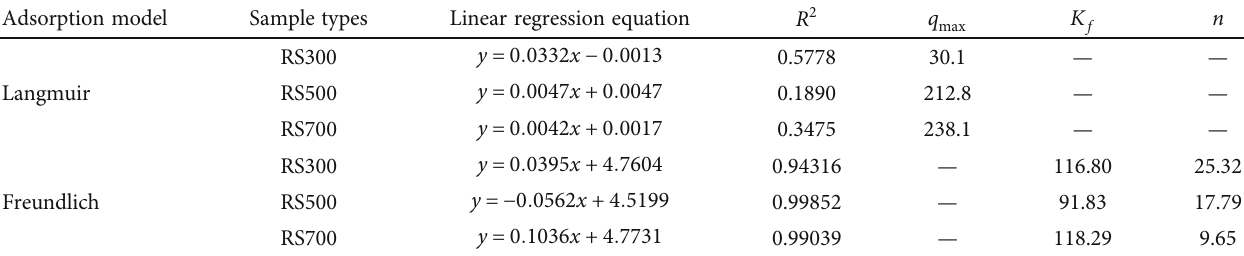
Table 4: Competitive adsorption model of Cu 2+ in acidic solution of straw carbon.